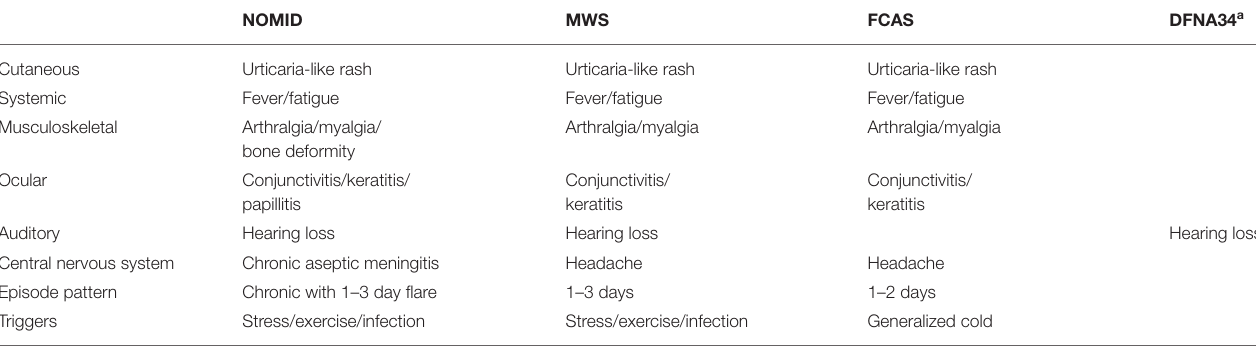
TABLE 1 | Clinical features of patients with CAPS (NOMID, MWS, and FCAS), and of those with non-syndromic sensorineural hearing loss